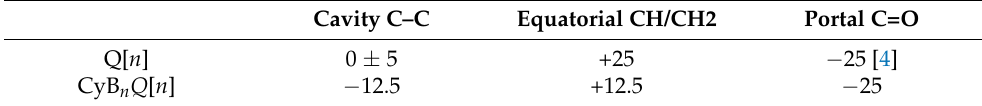
Table 3. A comparison of the β angle of the cis-fused junction of the glycoluril moieties of classical